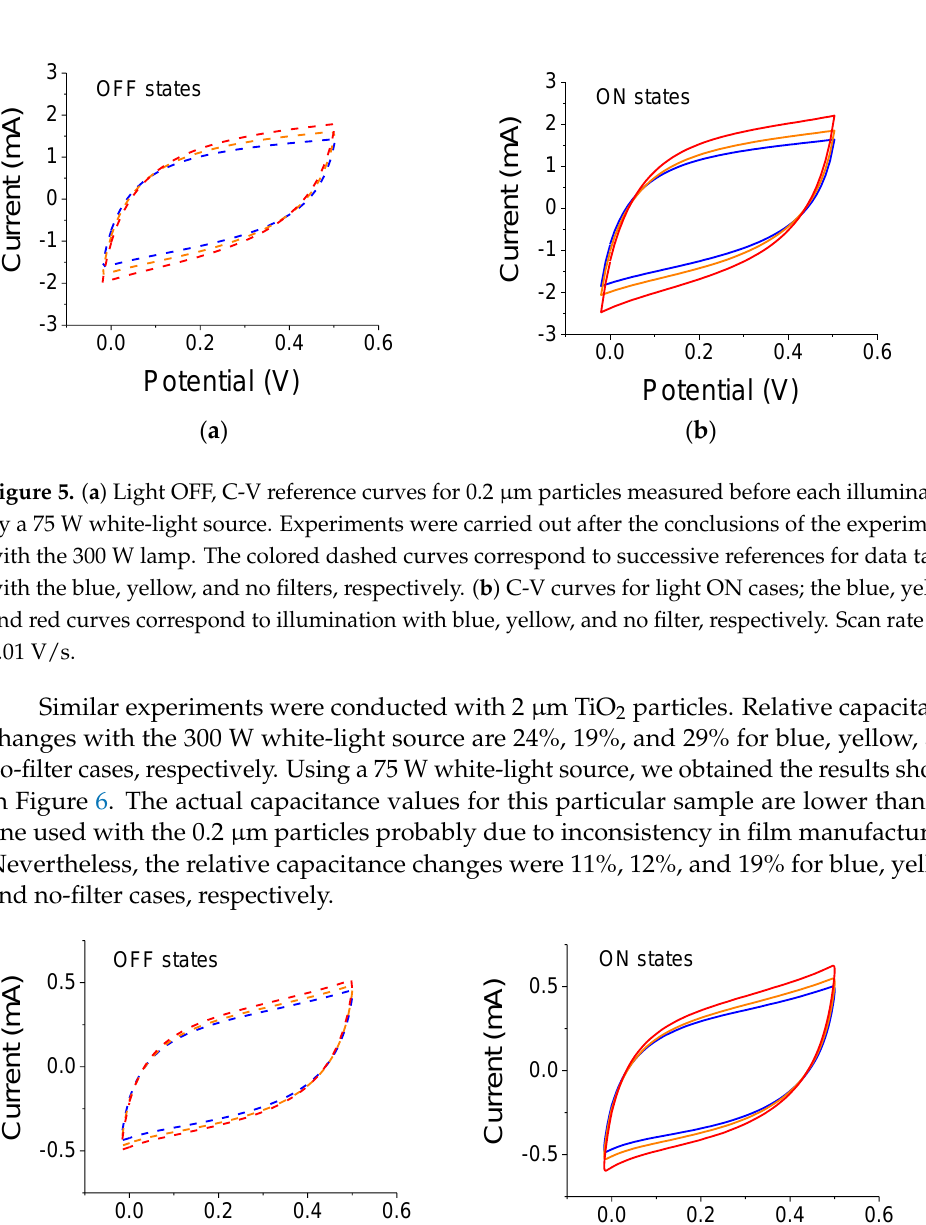
( b ) Figure 4. ( a ) Light OFF, C-V reference curves for 0.2 µm particles measured before each illumination by a 300 W white-light source. The colored dashed curves correspond to successive references for data taken with the blue, yellow, and no filter, respectively. ( b ) C-V curves for light ON cases; the blue, yellow, and red curves correspond to illumination with blue, yellow, and no filter, respec- tively. Table 2. Relative capacitive change using C-V measurements in a 3-electrode setting when illumi- nated by a 300 W white-light source. 29% Table 3. Relative capacitive change using a C-V measurements in a 3-electrode setting when illumi- nated by a 75 W white-light source.